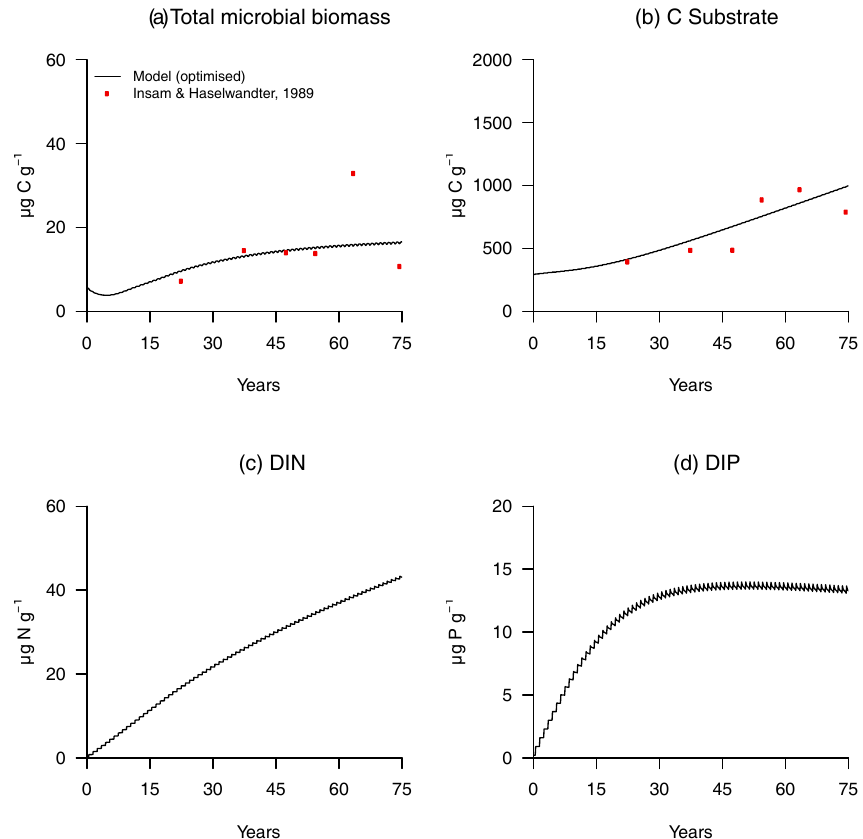
Figure 14. Model output optimised to observational data from the Athabasca Glacier, Canada.